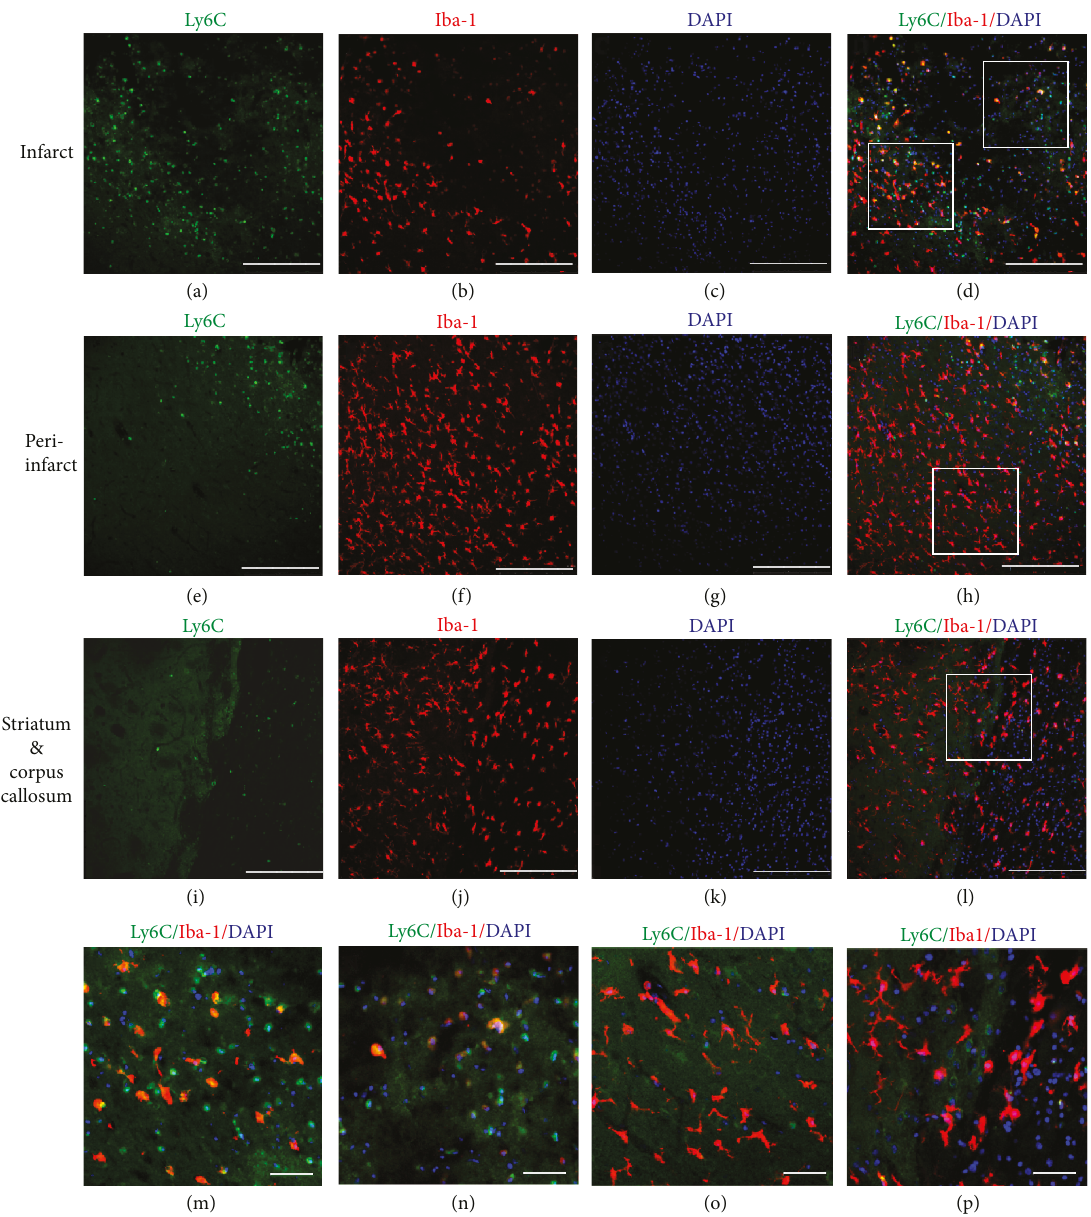
Figure 2: Few Ly6C + cells are double-stained with Iba-1 in the ischemia core cortex at day 2. (a – d) Distribution of Ly6C + and Iba-1 + cells in the infarct areas. (e – h) Distribution of Ly6C + and Iba-1 + cells in the peri-infarct area of the ipsilateral cortex. (i – l) Distribution of Ly6C + and Iba-1 + cells in the ipsilateral striatum and corpus callosum. (a, e, i) Ly6C staining. (b, f, j) Iba-1. (c, g, k) DAPI nucleus staining. (d, h, l) Double-stained Ly6C + /Iba-1 + cells. (d) Ly6C + /Iba-1 + cells scattered in the infarct area (right square) and the inner infarct boundary zone (left square). (h) Very few Ly6C + cells were found in the ipsilateral peri-infarct area (to the left of the dashed line). (l) Very few Ly6C + cells were found in the ipsilateral striatum (to the left of the dashed line) and corpus callosum (to the right of the dashed line), and no double stained Ly6C + /Iba-1 + cells were spotted in the striatum or corpus callosum. Arrow: double-labeled cells. Scale bar, 50 μ m. (m) (left square in (d)): in the inner infarct boundary zone, 30 – 40% of Ly6C + cells were Iba-1-positive. (n) (right square in (d)): in the infarct area, 20 – 30% of Ly6C + cells were Iba-1-positive. (o, p) (squares in (h) and (l)): very few or no double-stained Ly6C + /Iba-1 + cells was spotted in the striatum or corpus callosum. Scale bar: (a – l) 250 μ m and (m – p) 50 μ